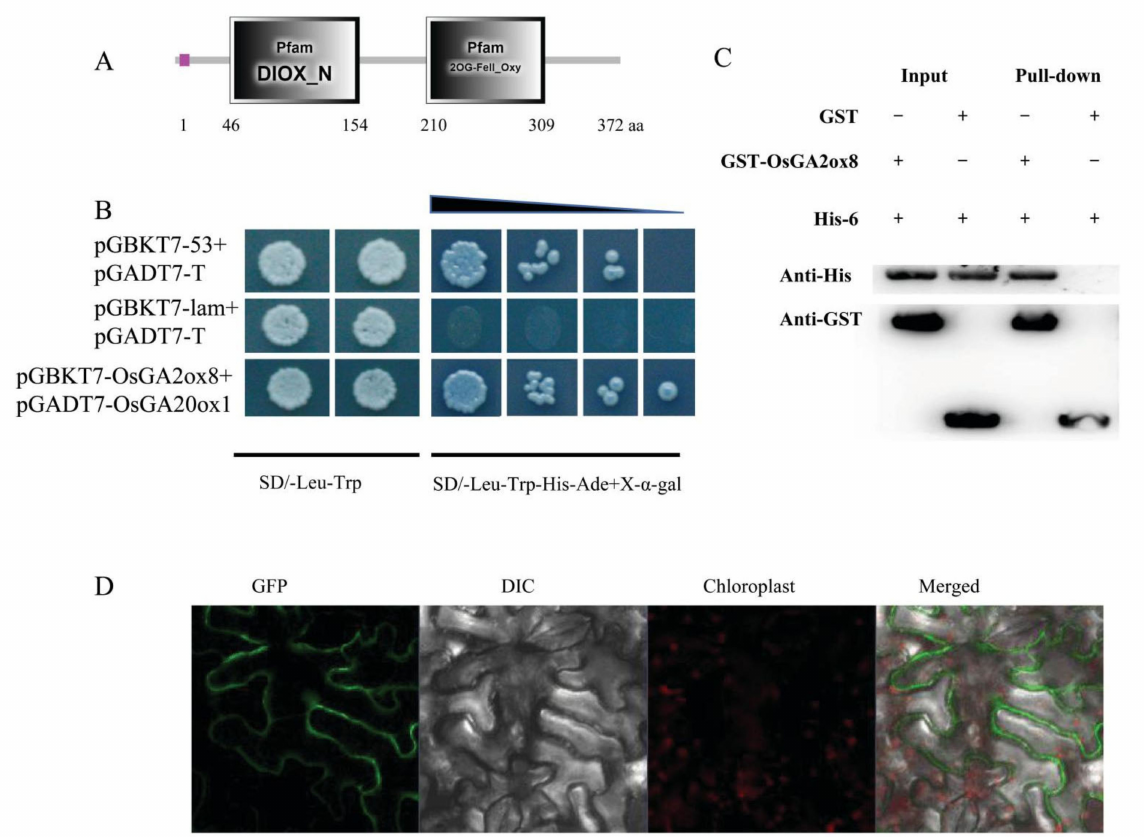
Figure 5. OsGA2ox8 interaction with OsGA20ox1. OsGA20ox1 contained two conserved domains: the non-heme dioxyge- nase domain and the 2OG-Fe (II) oxygenase superfamily domain ( A ). OsGA2ox8 interacted with OsGA20ox1 in a yeast two-hybrid assay ( B ), pull-down assay ( C ), and BiFC assay in Nicotiana benthamiana leaves ( D ). pGADT7-T was used as a positive control prey plasmid; pGBKT7-53 and pGBKT7-lam were used as positive and negative control bait plasmids, respectively. pnYFP-OsGA2ox8 and pcCFP-OsGA20ox1 were used in the BiFC